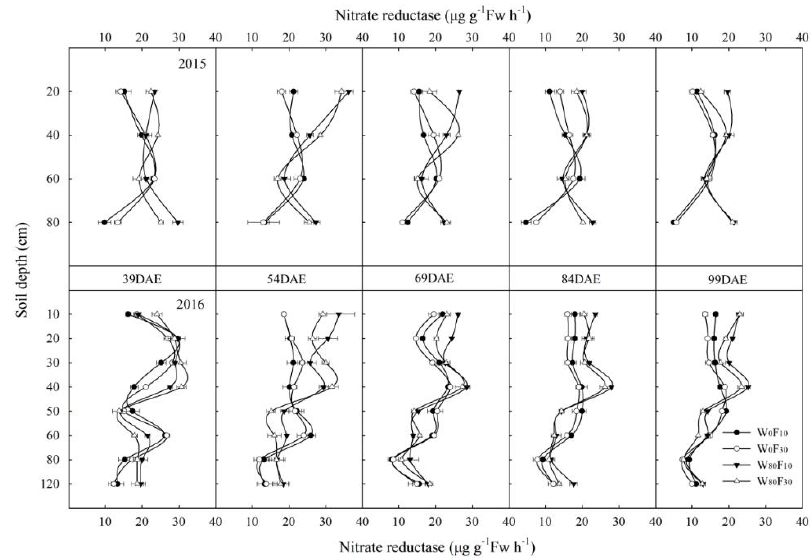
Figure 4. Changes in the nitrate reductase activity (μg g −1 FW h −1 ) in different vertical soil layer (from 0 to 120 cm soil layer) at pre-sowing irrigation (W 80 ) or no pre-sowing irrigation (W 0 ) and basal surface fertilization (F 10 ) or deep (F 30 ) application with the days after emergence (DAE) in 2015 and 2016. Bars indicate SD ( n = 3).